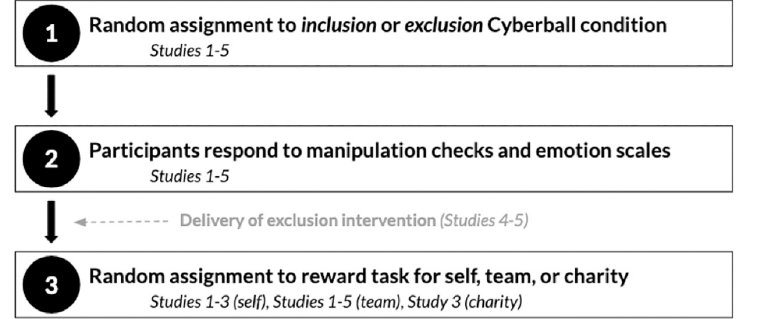
Fig 1. Main experimental steps for studies in the current